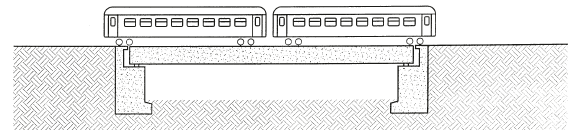
Figure 7: 45 m long concrete railway bridge excited by the passage of the